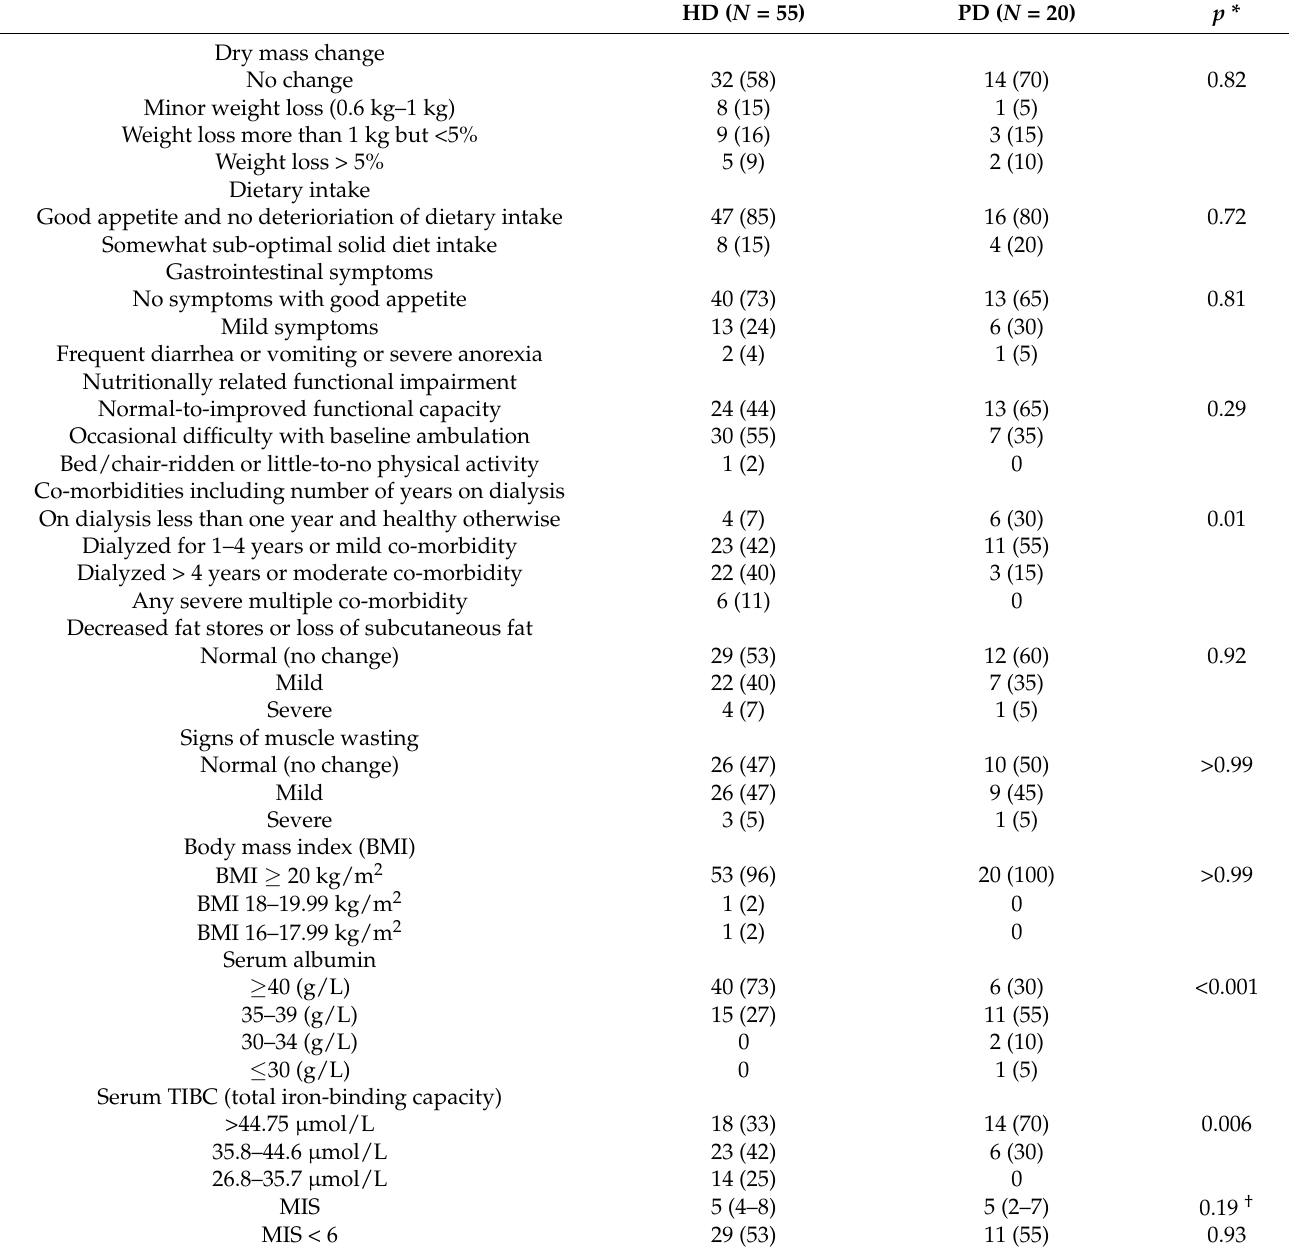
Table 4. Malnutrition Inflammation Score and differences regarding dialysis